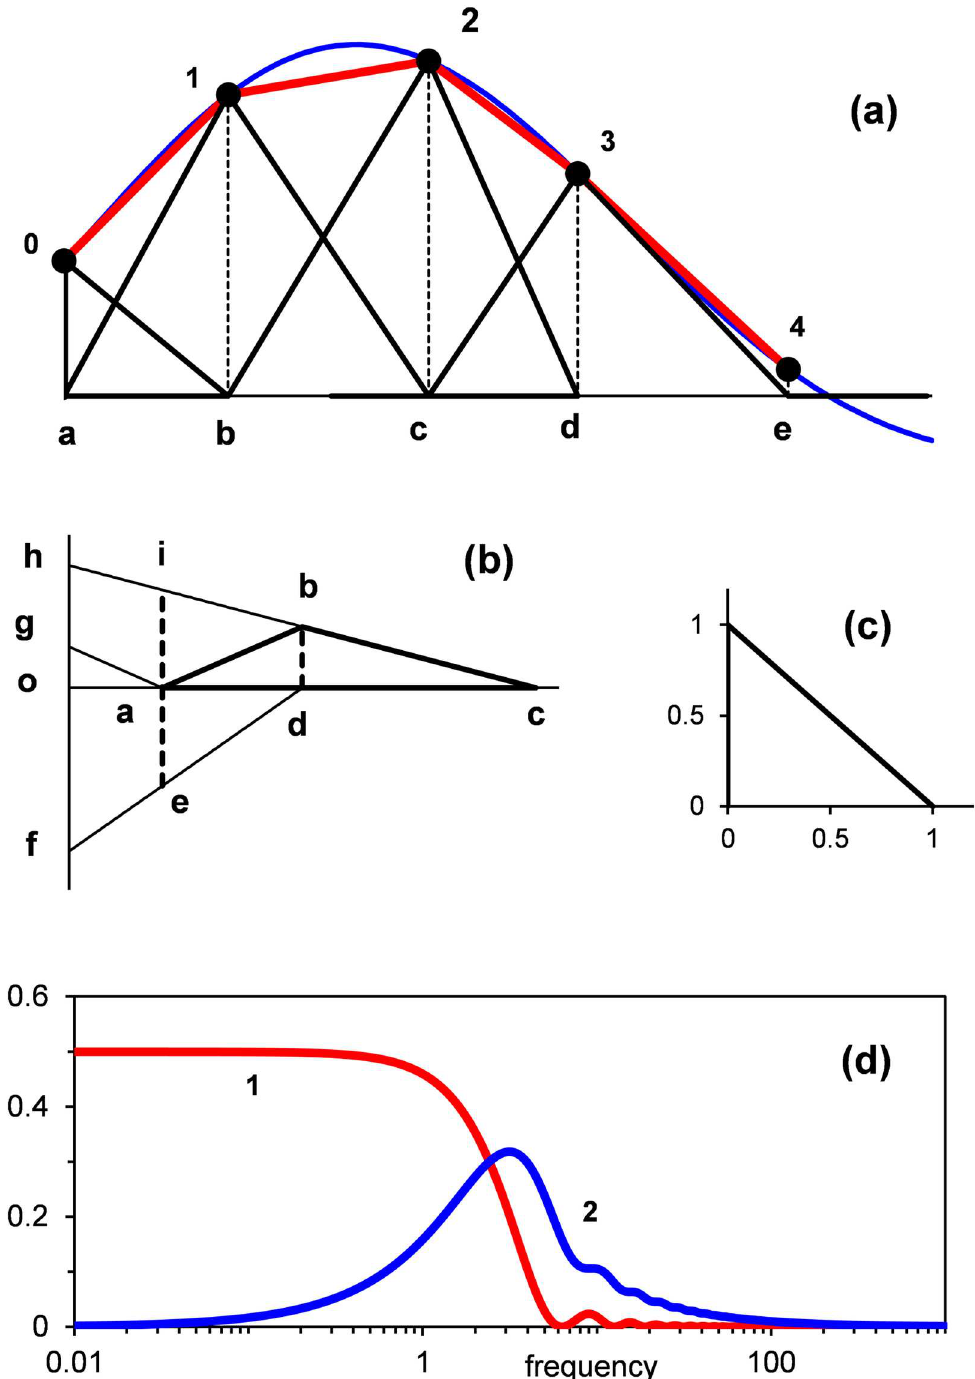
Fig 11. (a) Exemplifies a piece-wise linear interpolation of half-wave function. (b) Shows construction of the hat function (triangle abc ) as the sum of the triangles ohc , ofd and oga . (c) The triangular basis function. (d) The curves 1 and 2 show functions (26) and (27),